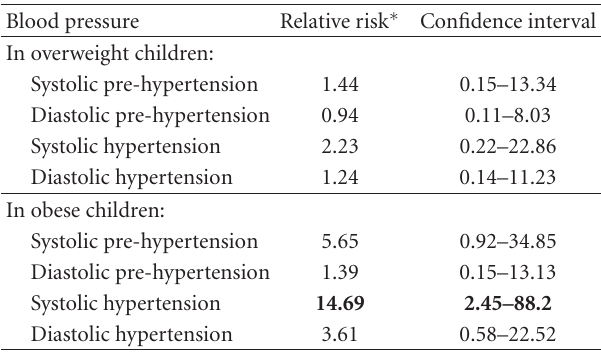
Table 4: Relative risk of hypertension by BMI category (adjusted for gender and family